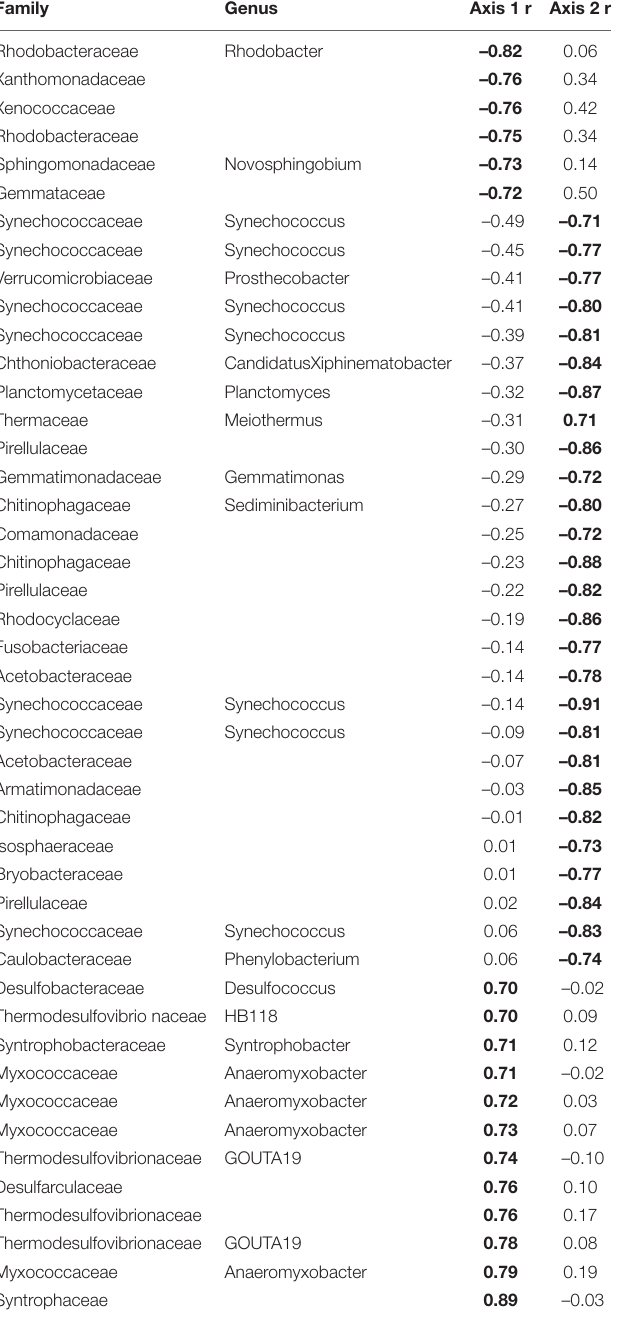
TABLE 2 | Axis loadings for PCA comparing sediment, shell, and biodeposit microbial communities. Family